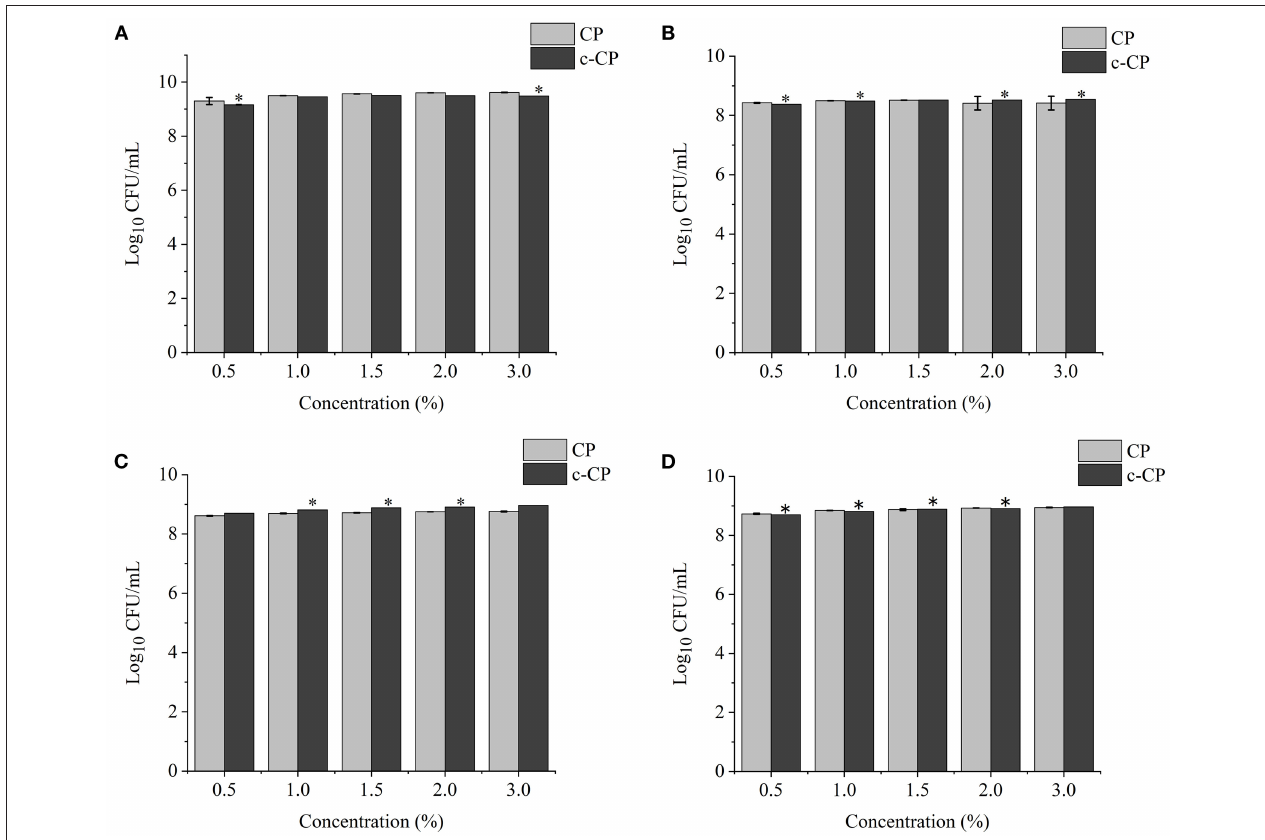
FIGURE 4 | Effects of different concentrations of carboxymethylated citrus pectin (c-CP) sample on the growth of (A) L. brevis , (B) L. plantarum , (C) L. delbrueckii subsp. bulgaricus , and (D) S. thermophilus . * P <